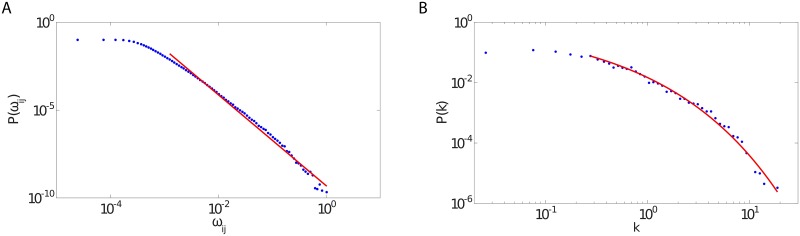
Weights and activities of the aggregate network.The distribution of the edge weights in the temporally aggregated network (left panel) shows a slow decay, with a tail that is well fitted by a power-law with exponent −2.59. The activities (right panel) follow instead a stretched exponential (Eq 2), with k* = 0.023 and α = 0.383. The values of τ used in the analysis are: (1 × 10−6, 5 × 10−6, 1 × 10−5, 5 × 10−5, 1 × 10−4, 5 × 10−4, 1 × 10−3, 2.5 × 10−3, 5 × 10−3, 7.5 × 10−3, 1 × 10−2, 2.5 × 10−2, 5 × 10−2).